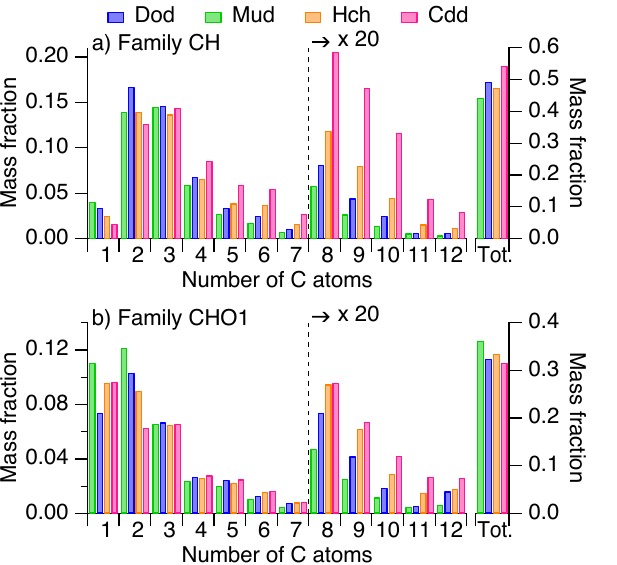
Fig. 7. Contribution of ions detected in the AMS to the bulk organic mass concentration for low-NO x alkane photooxidation. Ions are grouped into families according to the ion atomic composition and displayed as a function of carbon atoms in the ion. Tot. is the sum over all carbon atom numbers for each family. The data represent a 60min average of the SOA formed after 95–100% of the initial alkane had reacted. The data presented are from experiments DL2, ML2, HL2, and